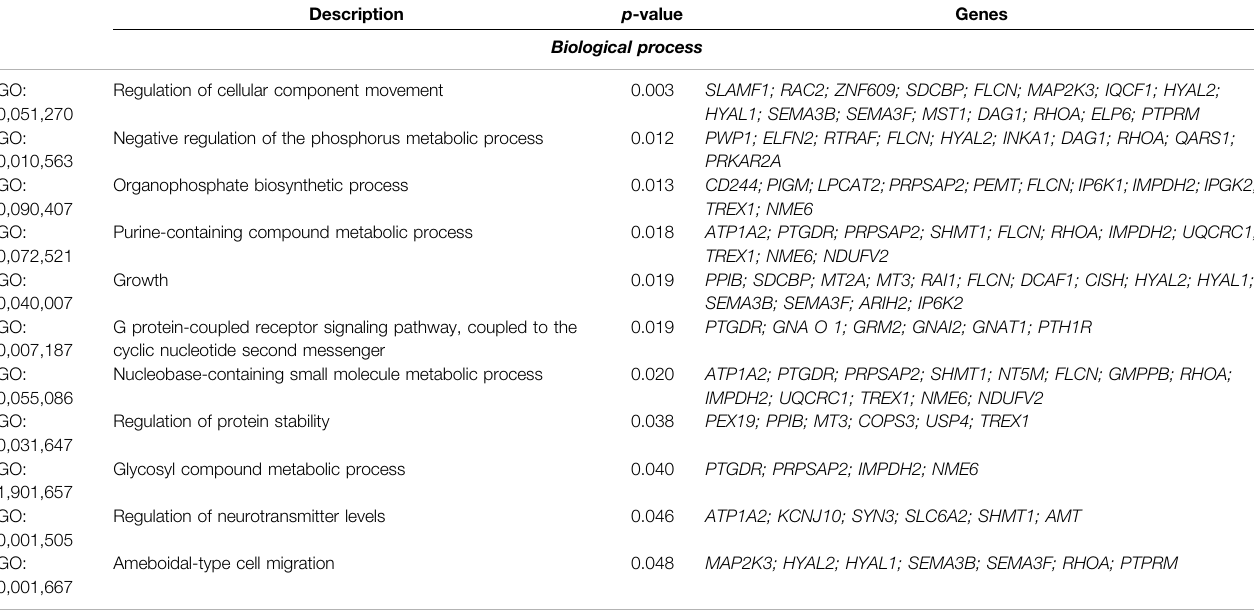
TABLE 5 | Signi fi cant ( p < 0.05) Gene Ontology (GO) terms, to biological process, to heterozygous-enriched regions found in the Purunã breed. Description p -value